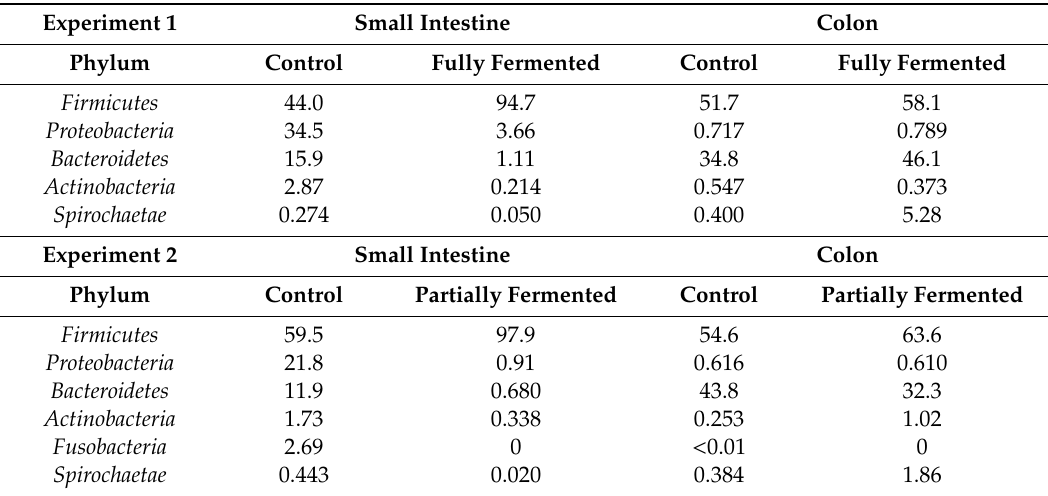
Table 3. Relative abundance (%) of bacterial phyla depending on the dietary treatment and sampling point in Experiment 1 and Experiment 2.